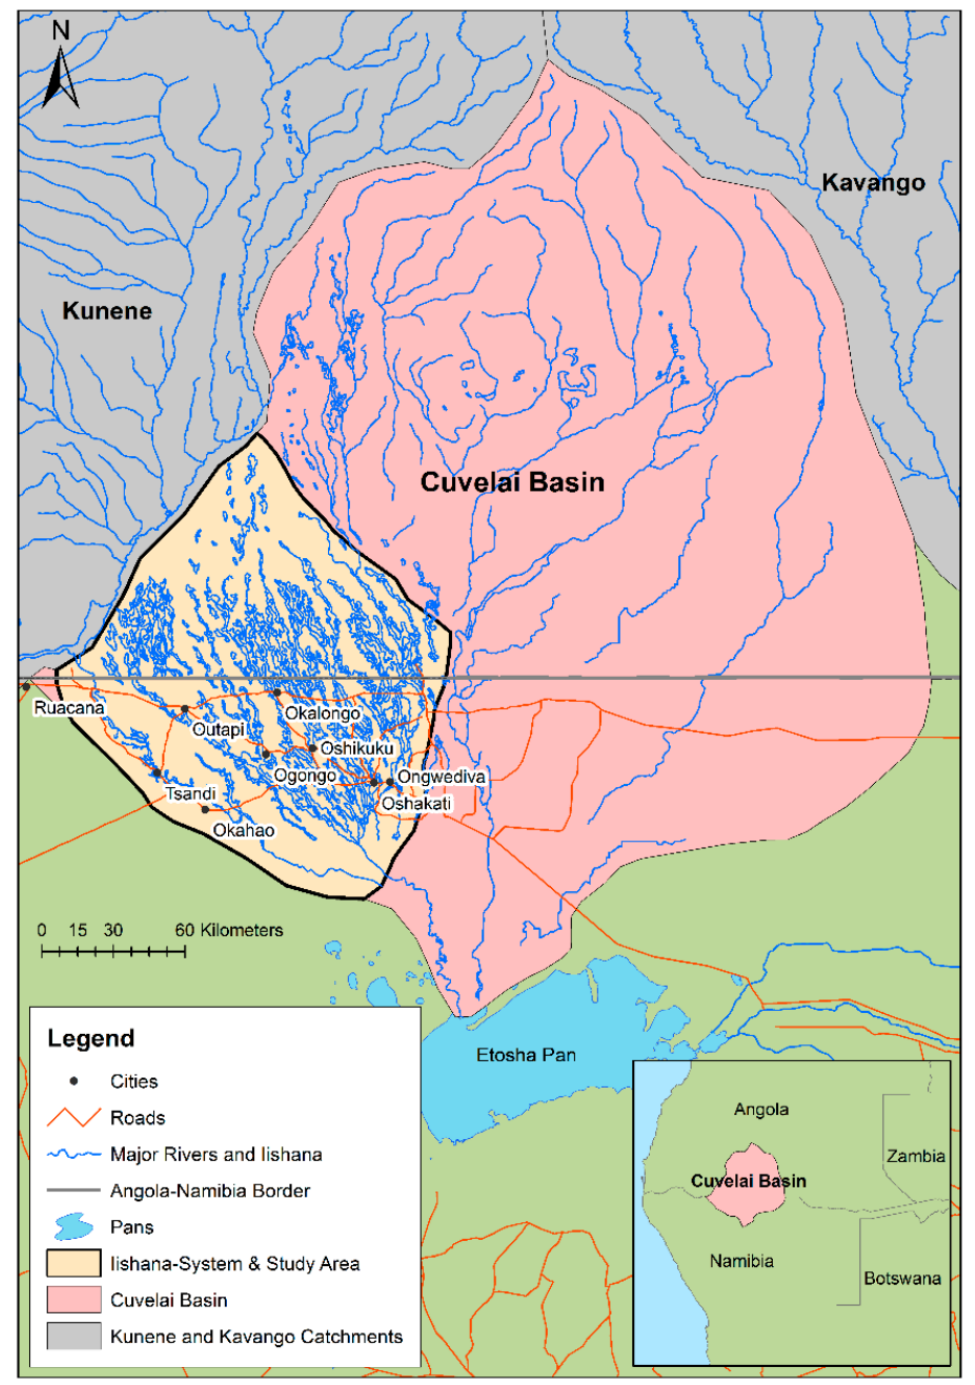
Figure 2. Overview of the Cuvelai Basin and the study area of the Iishana-System, database: